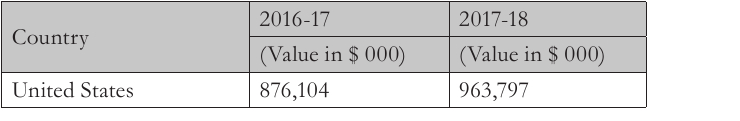
Tab. 1 – Export of Knitwear (Hosiery) Garments by country. Source: Trade Development Authority of Pakistan, taken from Memon, N. A.